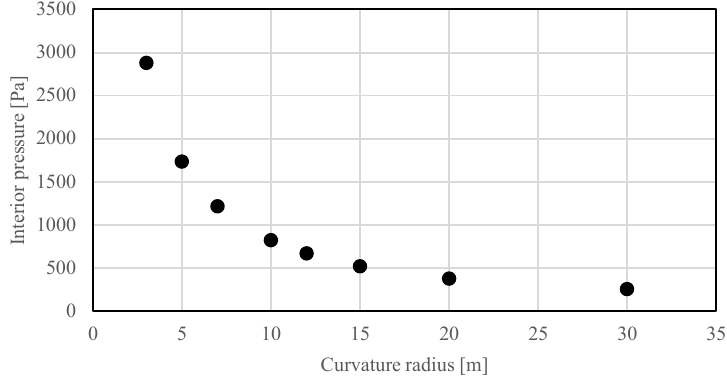
Fig. 3 Internal pressure vs. curvature radius for the reference cylindrical panel of the parametric study.